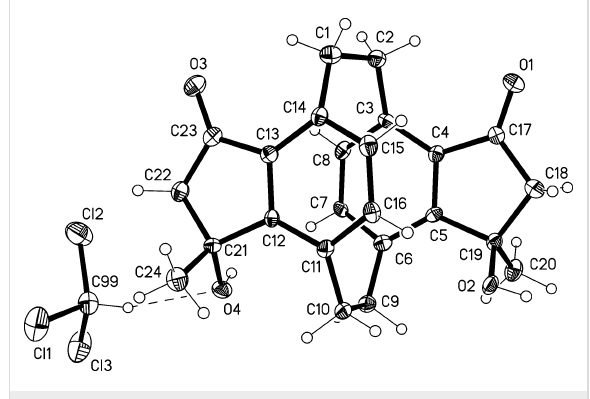
Figure 1: Structure of 12· CDCl 3 in the crystal. Ellipsoids represent 50% probability levels. Selected bond lengths (Å) and angles (°): C1–C2 1.573(11), C9–C10 1.579(11), C14–C1–C2 112.8(7), C1–C2–C3 112.1(6), C6–C9–C10 113.0(7), C9–C10–C11 112.1(7), C4–C3–C8 114.8(8), C5–C6–C7 115.3(7), C12–C11–C16 116.2(7), C13–C14–C15 115.1(8). The dashed line indicates a weak hydrogen